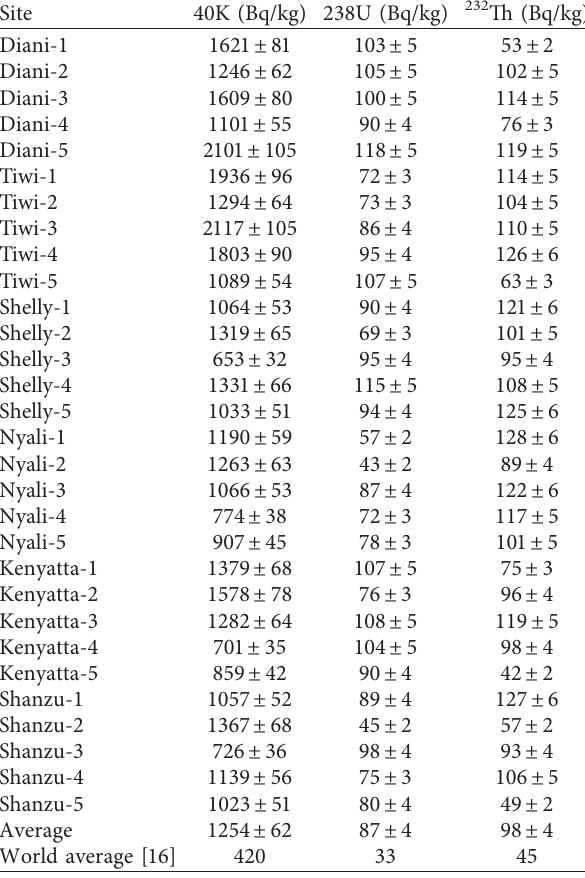
Table 1: Activity concentration of 40 K, 238 U, and 232 Th in the sand samples in this work.